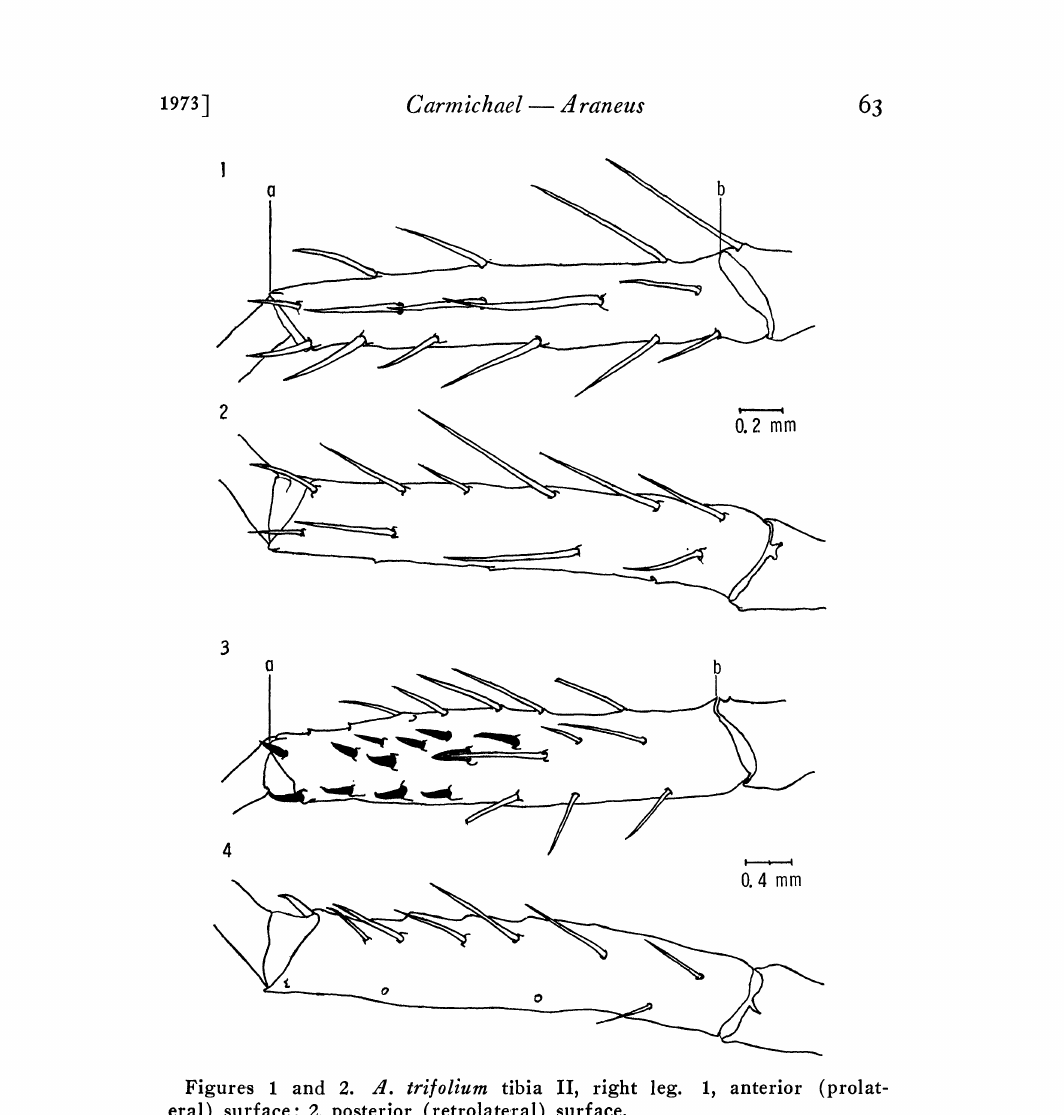
and 2. d. trifolium tibia II, right leg. 1, anterior (prolat- eral) surface 2, posterior (retrolateral) surface. Figures and 4. d. marmoreus tibia II, right leg. The dentiform spines are blackened. 3, anterior (prolateral) surface; 4, posterior (retrolateral) surface. Note the difference in scale between 1, 2 and 3,